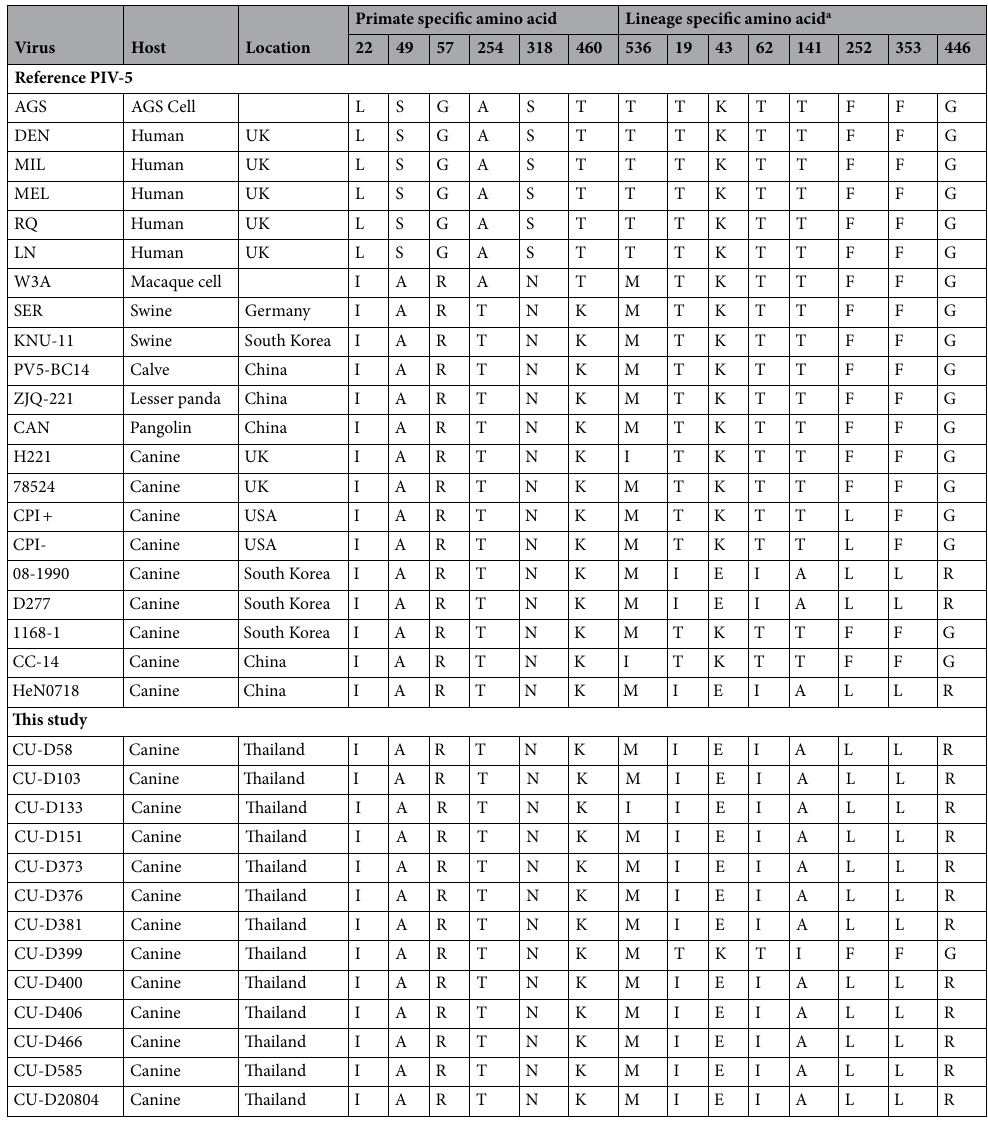
Table 4. Genetic analysis of the HN gene of Thai CPIV-5 and reference PIV-5 at the human-specific residues. a Lineage: CPIV-5 sublineage; Thai, Chinese, and Korean